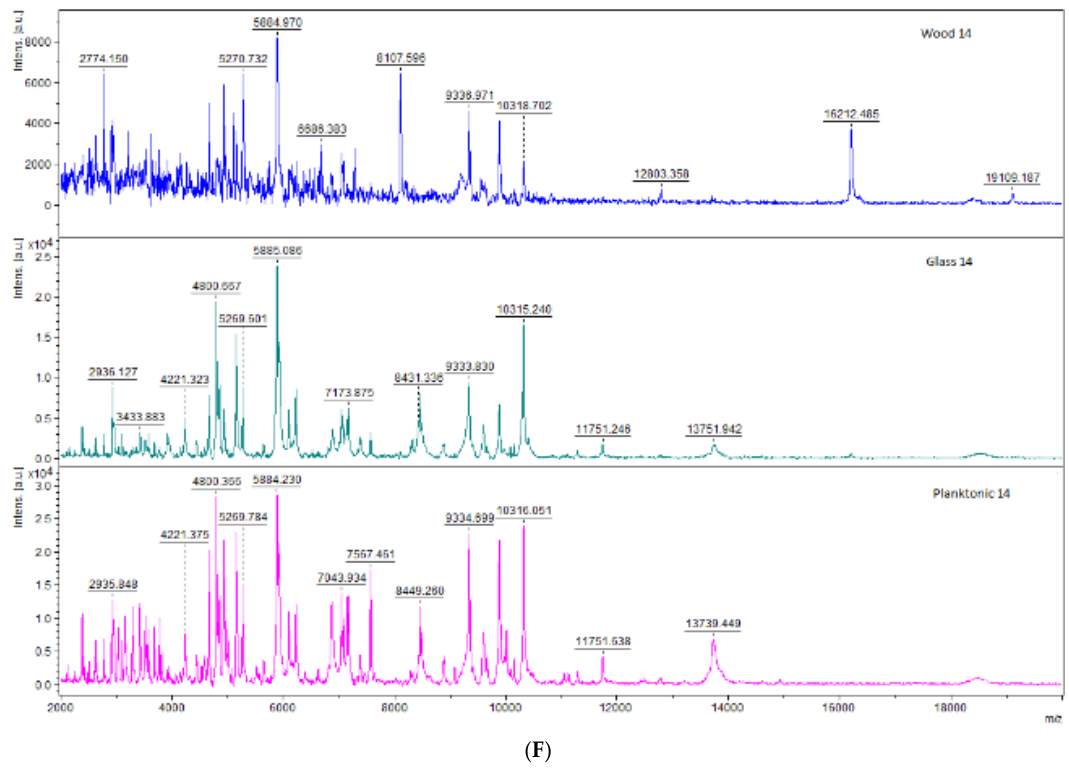
Figure 1. Representative MALDI-TOF mass spectra of S. maltophilia : ( A ) 3 days; ( B ) 5 days; ( C ) 7 days; ( D ) 9 days; ( E ) 12 days; and ( F ) 14 days.